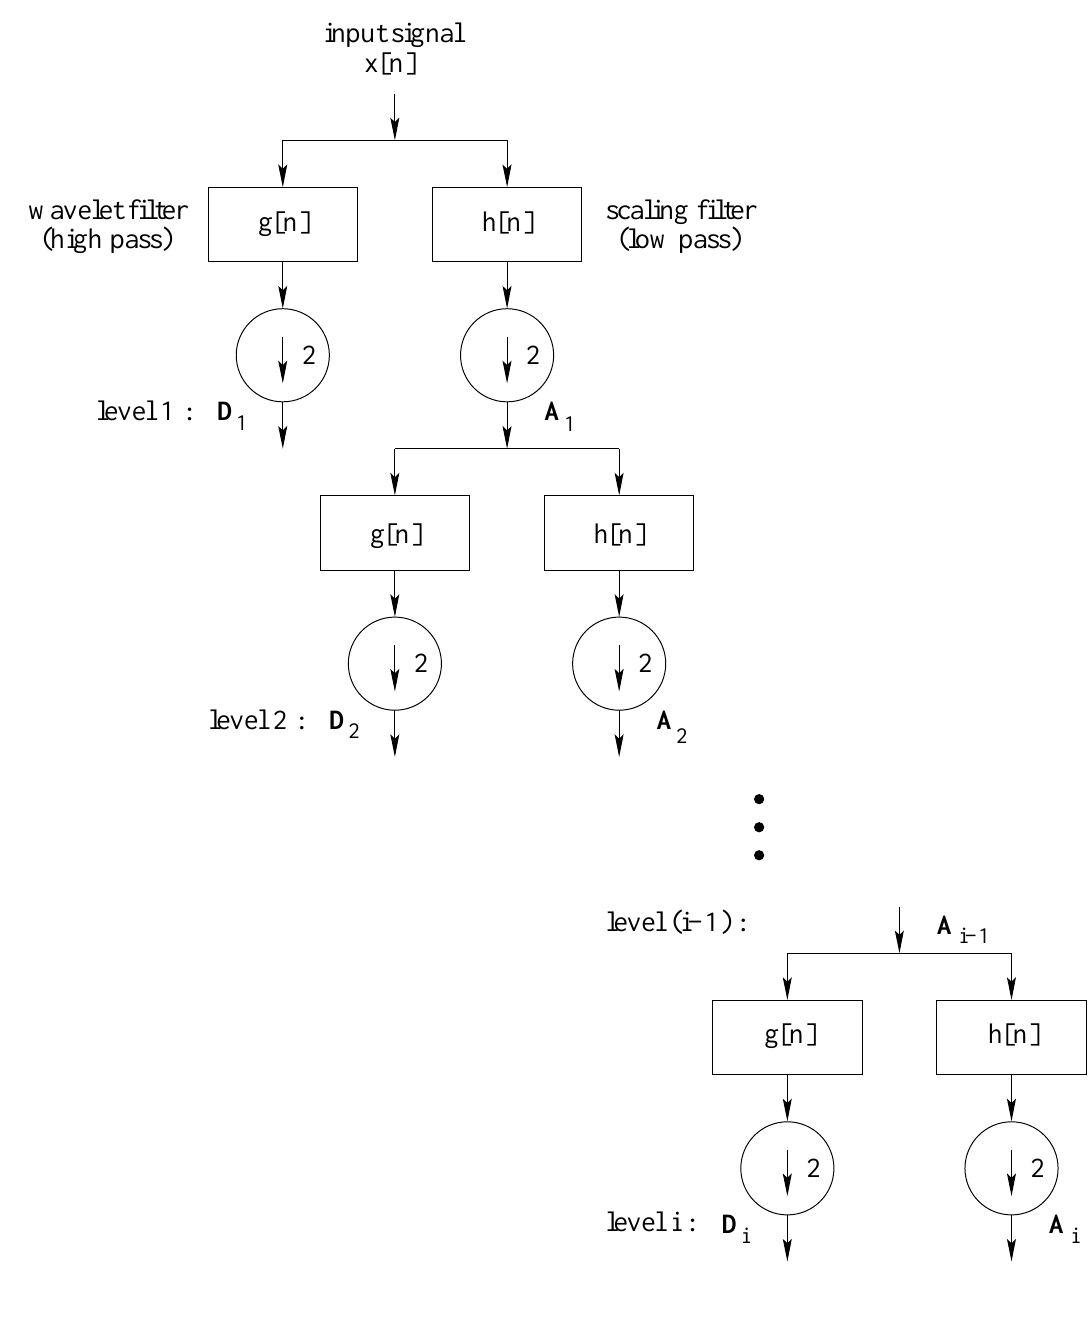
Figure 6. Decomposition of a signal x [ n ] with DWT at level i